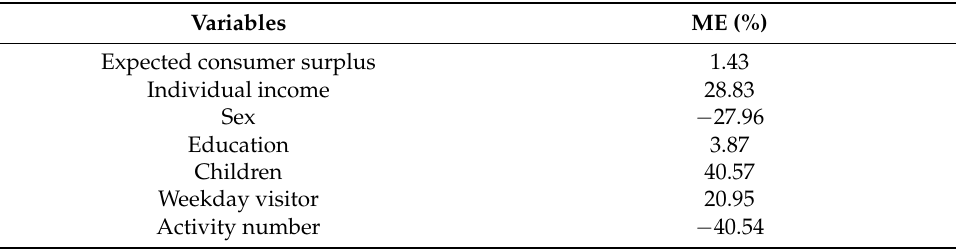
Table 6. Marginal effects of variables in the trip-demand